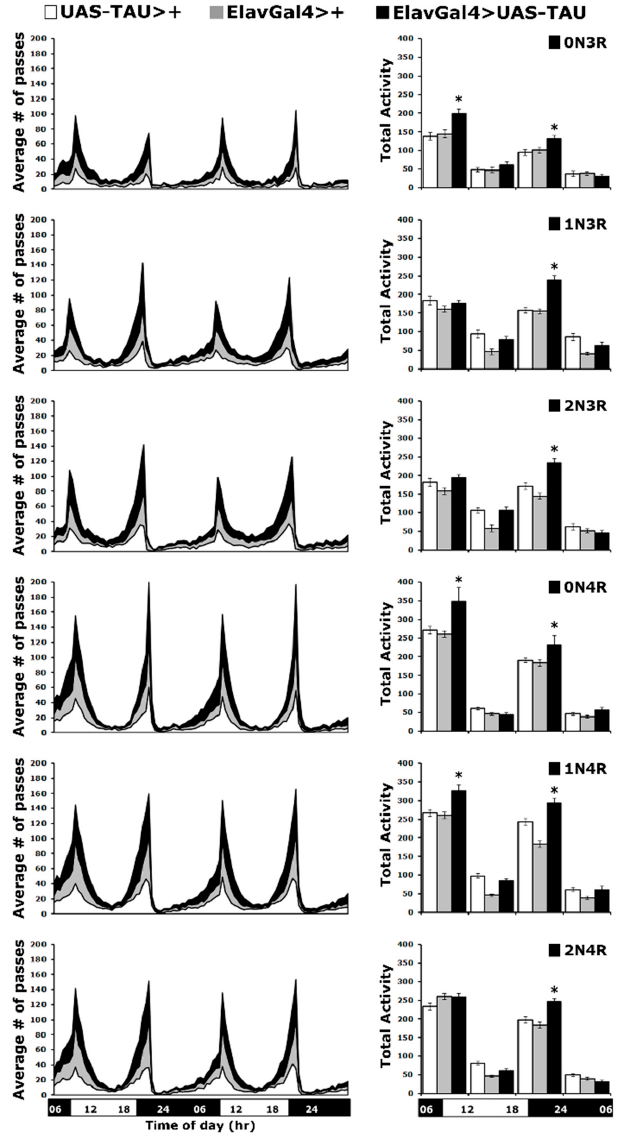
Figure 6. Circadian locomotor activity is affected by all hTau isoforms. Locomotor activity of animals accumulating pan-neuronally the indicated hTau isoforms under elavGAL4 (black bars) compared with driver and transgene heterozygotes (grey and white bars). Flies were monitored for 2 days at 25 °C in a 12 h light/dark cycle. Representations of the average activities of the indicated genotypes monitored in 30-min bins over two days (left panel) divided in four 6-h intervals (early day: 0600–1130, late day: 1200–1730, early night: 1800–2330 and late night 2400–0530 h) as indicted by the light on (white) and off (black) and bar on the bottom of the graph. Total activities shown as means ± SEMs for each quarter day for animals accumulating the indicated isoform and relevant controls are indicated on the right. Stars (*) indicate significant differences from both controls. n ≥ 50 flies per genotype. Statistical details in Supplemental Table S6.